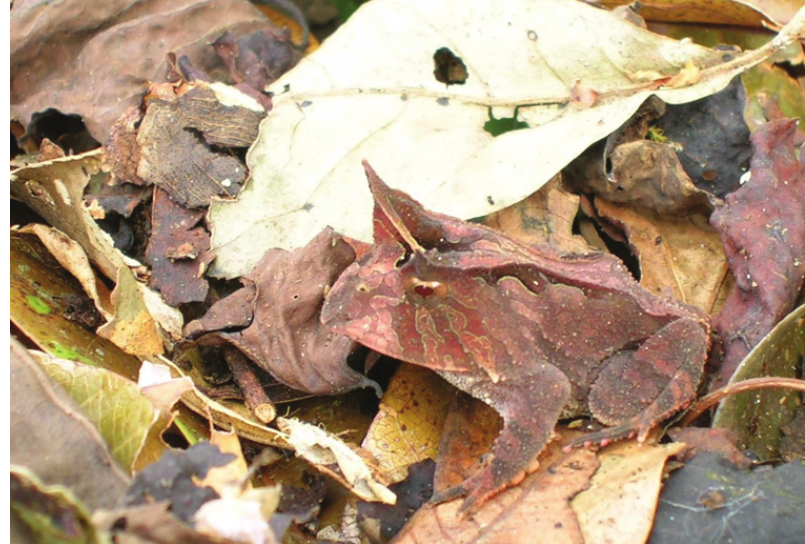
Fig. 1 – Proceratophrys boiei , Estação Ecológica Estadual do Paraíso, Rio de Janeiro, Brasil. Foto: Klaion,